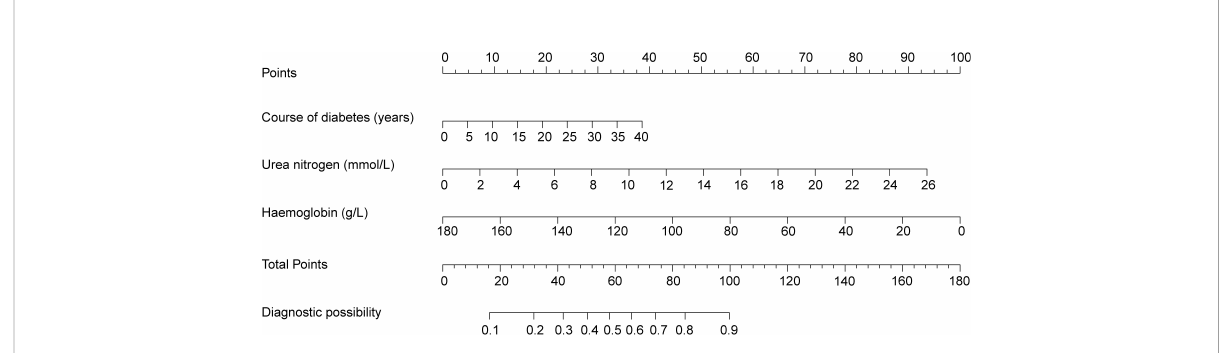
FIGURE 2 Nomogram predicting peripheral artery disease possibility of type 2 diabetes mellitus patients.